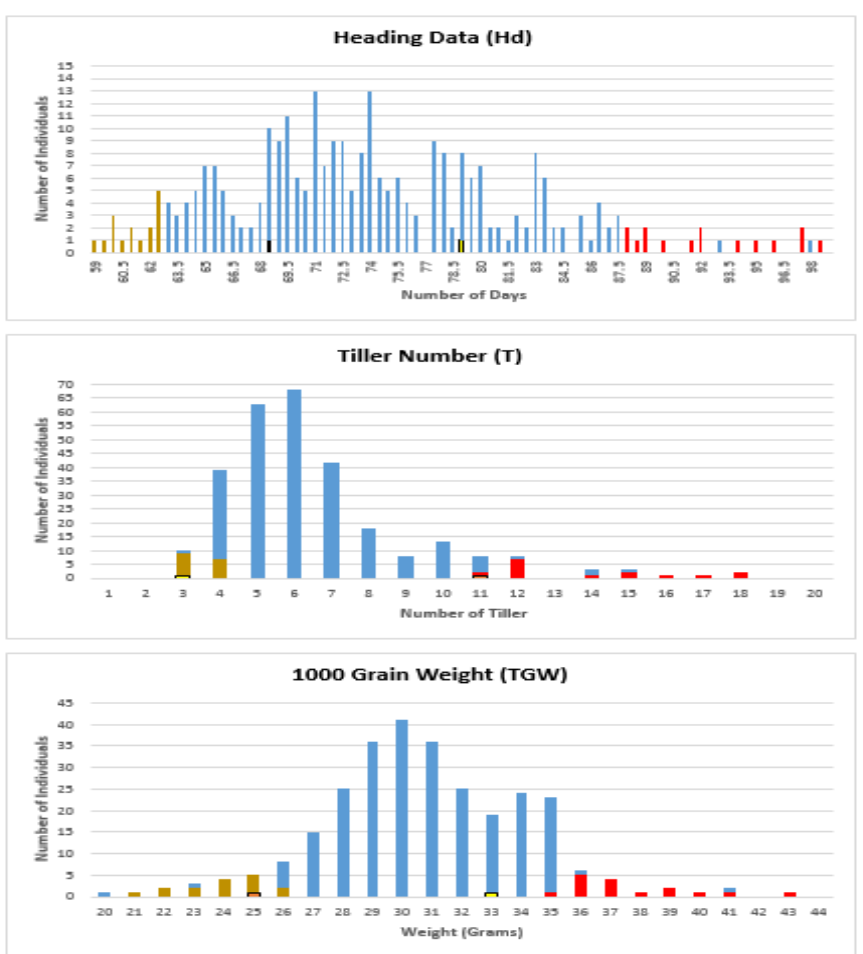
Figure 1. Frequency distribution of heading date (Hd), tiller number at maturity (T), and 1000 grain weight (TGW) traits within a population of 285 individuals. “X” represents the values of traits (days, tiller count, and gram, respectively) while “Y” represents individuals’ count. The selected individuals of two extreme phenotypic bulks, low and high, are marked in brown and red, respectively.